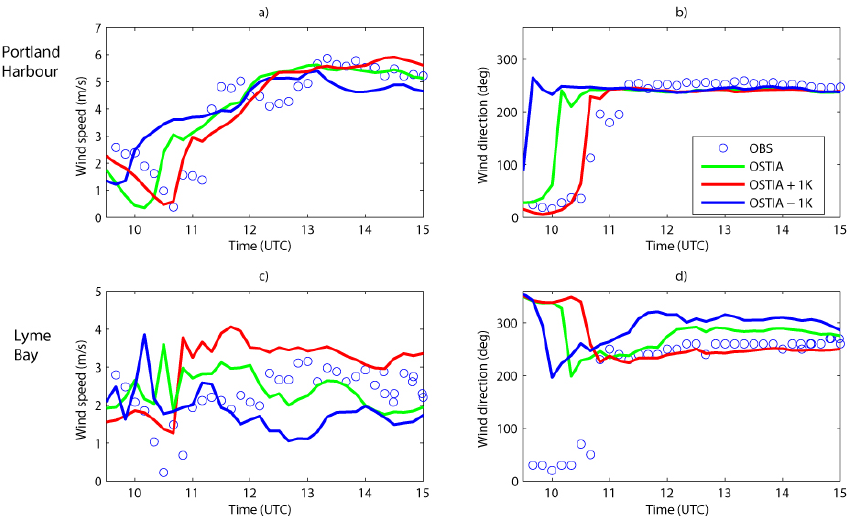
Fig. 5. A comparison of observed and simulated 10m wind speed and direction at the Portland Harbour and Lyme Bay observational Sweeney, Chagnon, Gray: The e ff ect of SST and orography on the sea breeze 7 platforms. Modeled and observed data are plotted at 10min intervals. (Data supplied by the Channel Coastal Observatory.)